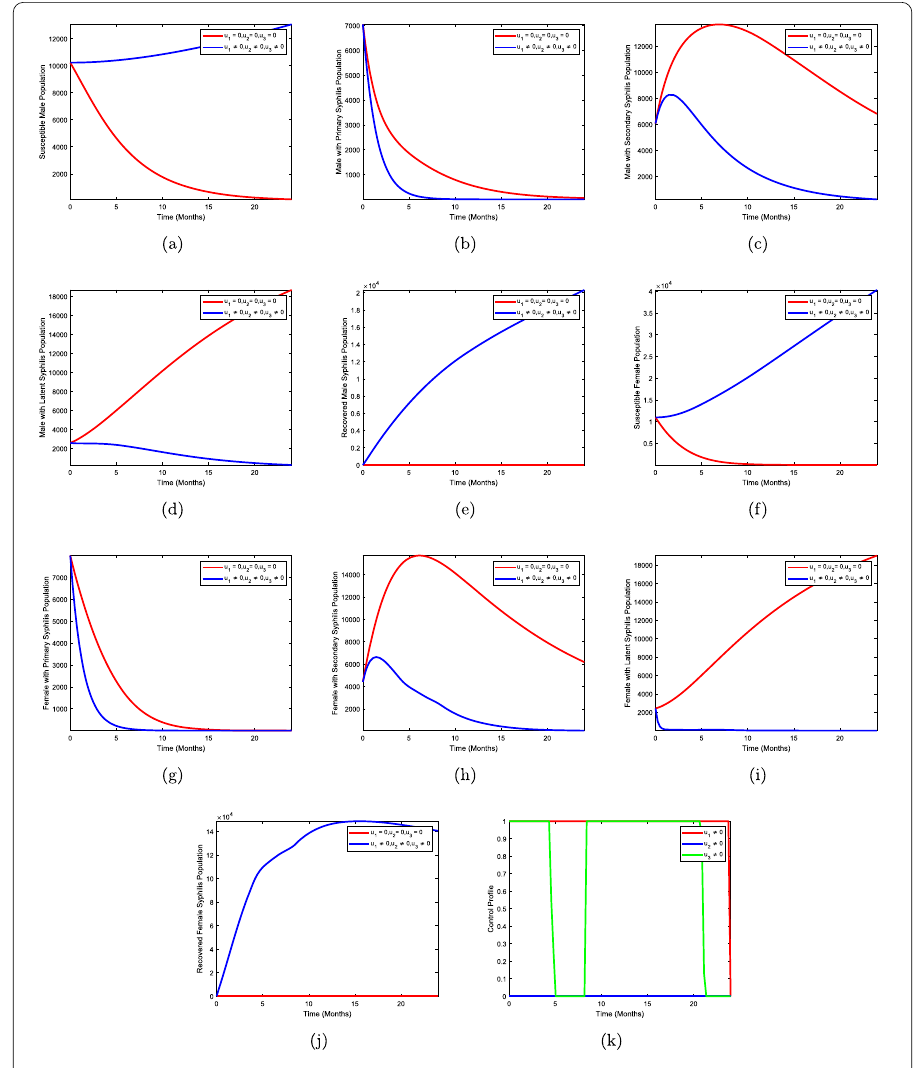
Figure 5 Use of condom + treatment of male with syphilis infection + treatment of female with syphilis infection